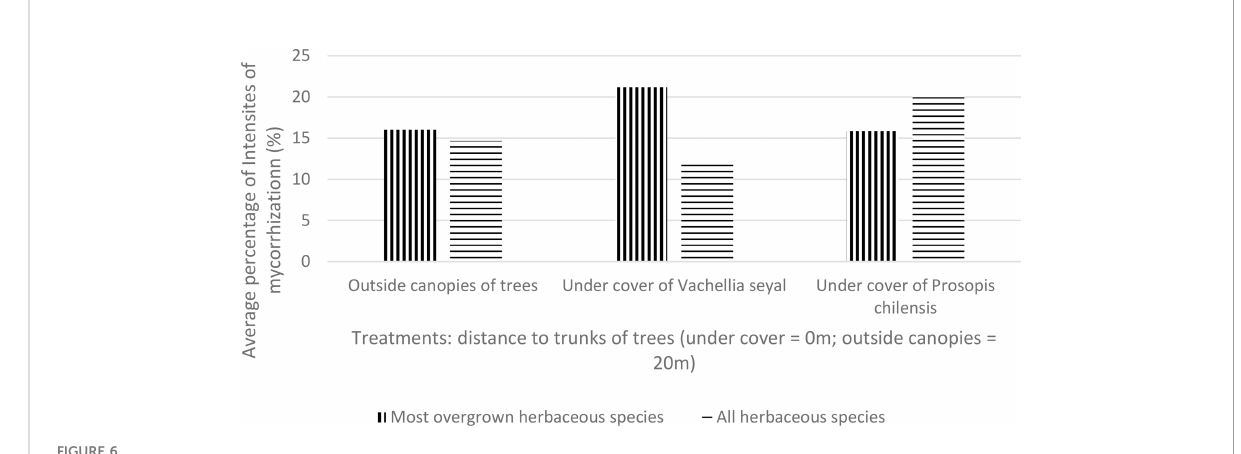
FIGURE 6 Mycorrhization rate of natural living roots of herbaceous species beneath the trees and outside the canopies of